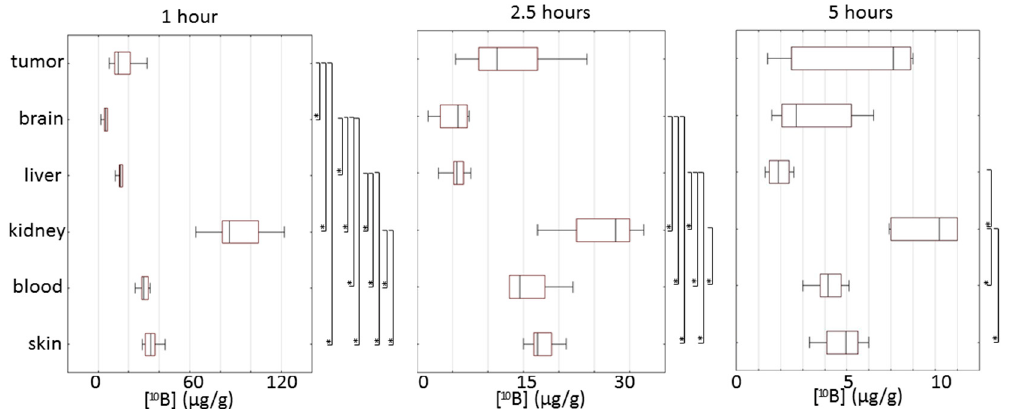
Figure 3. Box plots of absolute concentration of boron in different tissues at 1, 2.5 and 5 h after injection of BPA. Box borders indicate the 25th and the 75th percentiles (interquartile range); lines within boxes indicate the median. Significance of differences for 10B uptake in tissues was defined by a Mann–Whitney pairwise comparison followed by a Bonferroni post-test. * Statistical difference at p < 0.05.